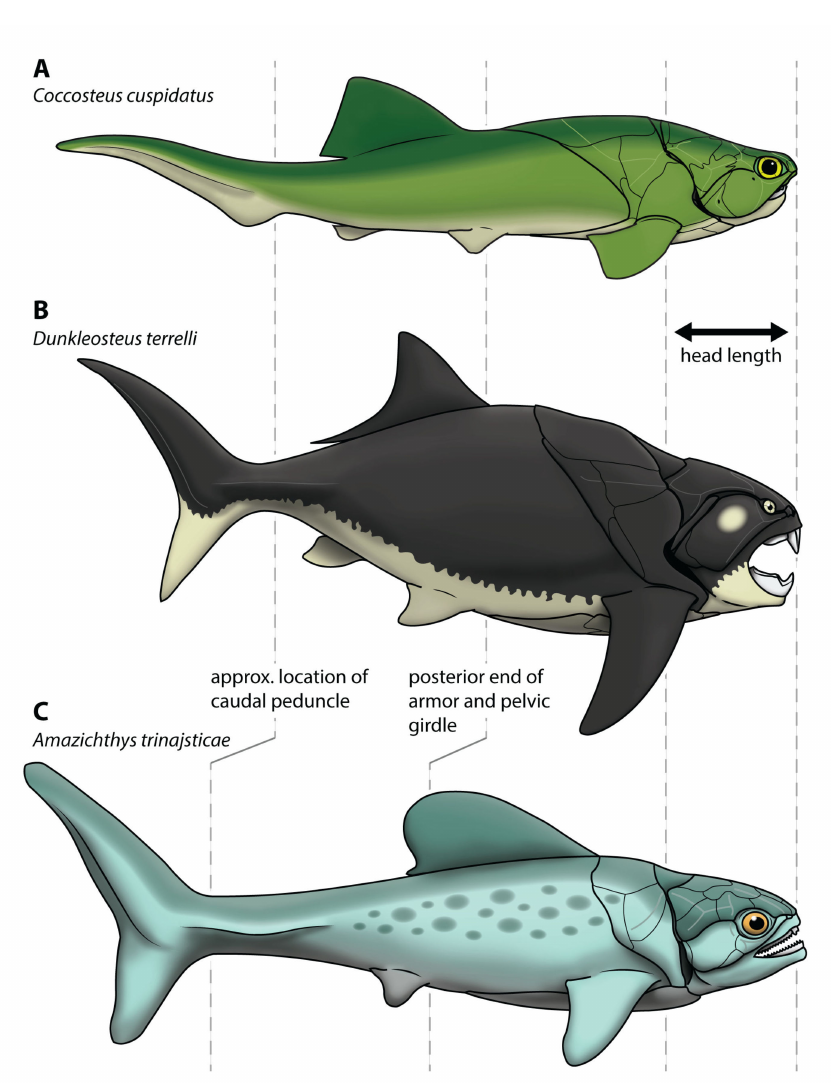
Figure 11. Reconstructions of ( A ) Coccosteus cuspidatus (modeled after [15,200]), ( B ) Dunkleosteus terrelli , and ( C ) Amazichthys trinajsticae (proportions modeled after [21]), scaled to the same head length. The shorter lengths for Dunkleosteus terrelli in the present study better agree with the locations of the pelvic girdle/posterior end of the ventral armor and caudal peduncle in other arthrodires. A. trinajsticae also shows a more elongate body plan than other arthrodires (especially if scaled based on OOL rather than head length, as here). Missing elements of Amazichthys modeled after Draconichthys , Gymnotrachelus , Stenosteus , and Trachosteus . Drawings by Russell Engelman. The other observation that supports a shorter length for Dunkleosteus terrelli is the likely position of the anus. Trinajstic et al. [57] report the opening of the anus in Incisoscutum is located just posterior to the posteroventrolateral plates, where the pelvic girdle would have been. This agrees with the location of the anus relative to the claspers and pelvic girdle in extant chondrichthyans [201]. This is also the case in AMNH FF 2826 (referred to Heintzichthys gouldii ), the only other arthrodire that preserves evidence of the location of the cloaca [26]. In this specimen, there are preserved gut contents (possibly the coprolitic infilling of a spiral intestine) that extend beneath the spinal column just posterior to